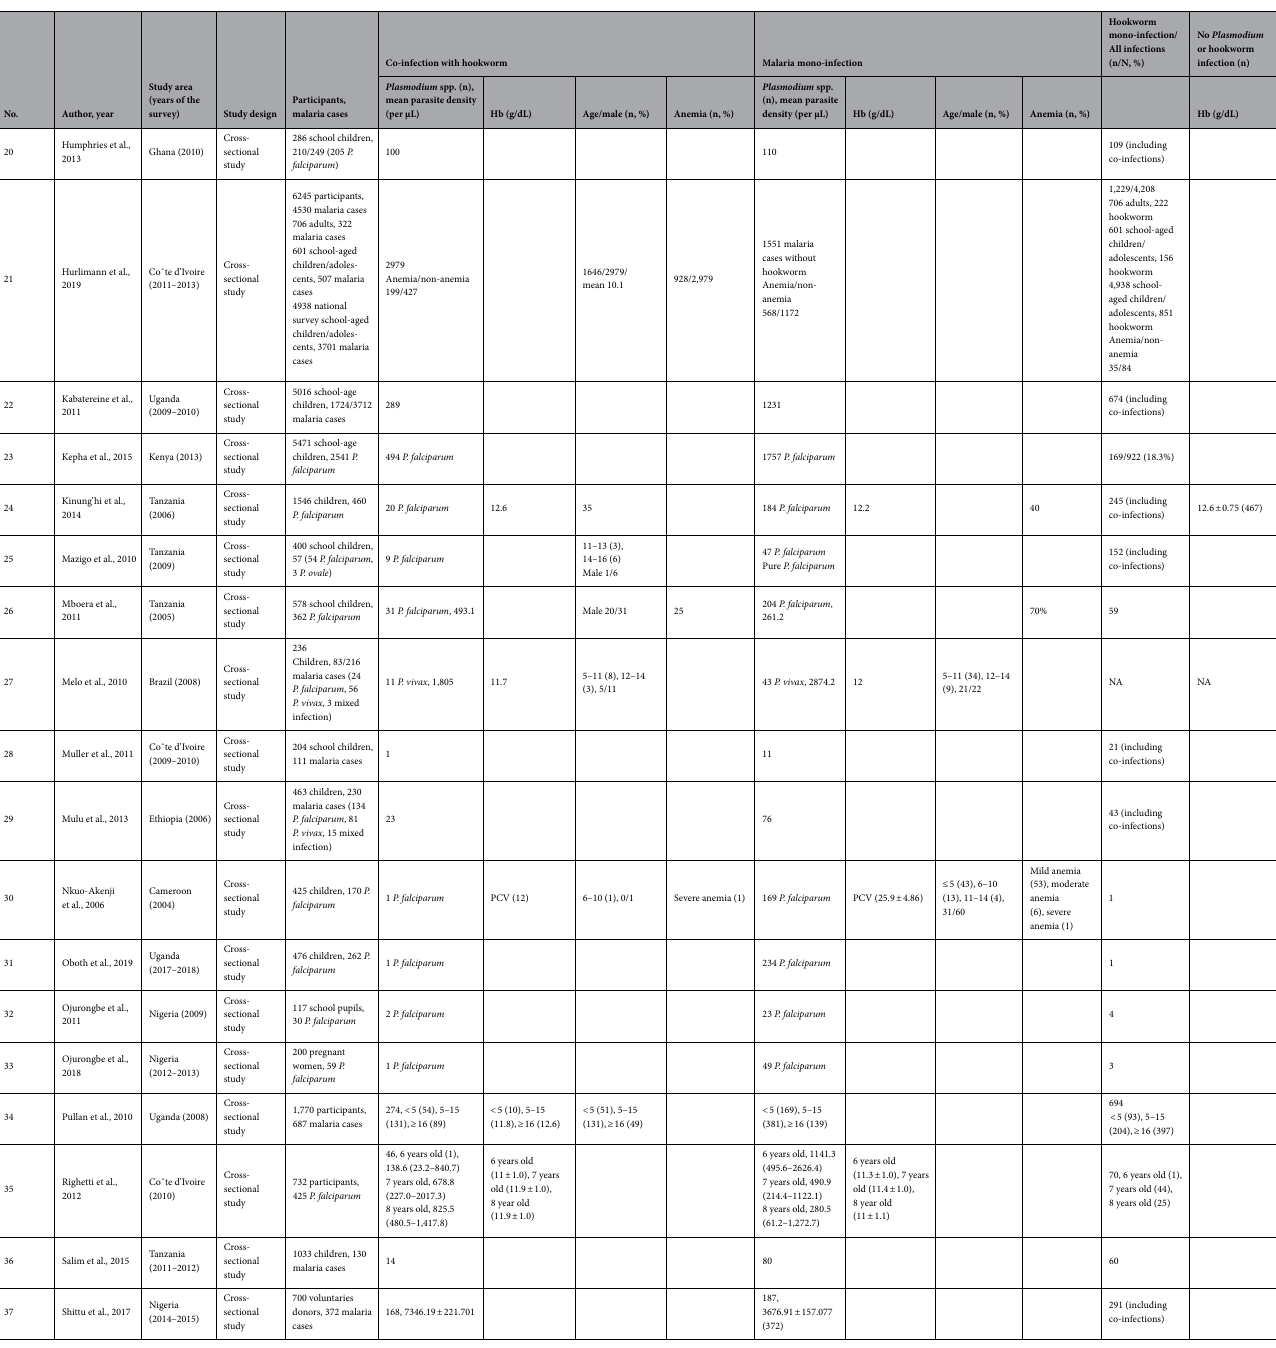
than in Plasmodium mono-infection, whereas one study 38 demonstrated a higher mean haemoglobin level in co- infection than in Plasmodium mono-infection (Fig. 6). The pooled MD of haemoglobin between patients with co-infection (79 cases) and without any infection (645 cases) was estimated from three studies 8,9,38 . The results demonstrated no difference in the mean haemoglobin level between patients with co-infection and without any infection when a random effects model was used ( p 0.062, MD − 1.4, 95% CI − 2.87 to 0.07, I 2 98.8%) (Fig. 7). Publication bias. Publication bias was assessed using the funnel plot demonstrating the effect size (pooled OR) and selogES from 30 studies (Fig. 8). Egger’s test demonstrated that no small-study effect was found (p 0.128, coefficiency 6.77, standard error 4.31). Visualisation of the funnel plot and the result of Egger’s test dem- onstrated asymmetrical distribution of the funnel plot, and no small-study effect was found among the included studies, respectively.